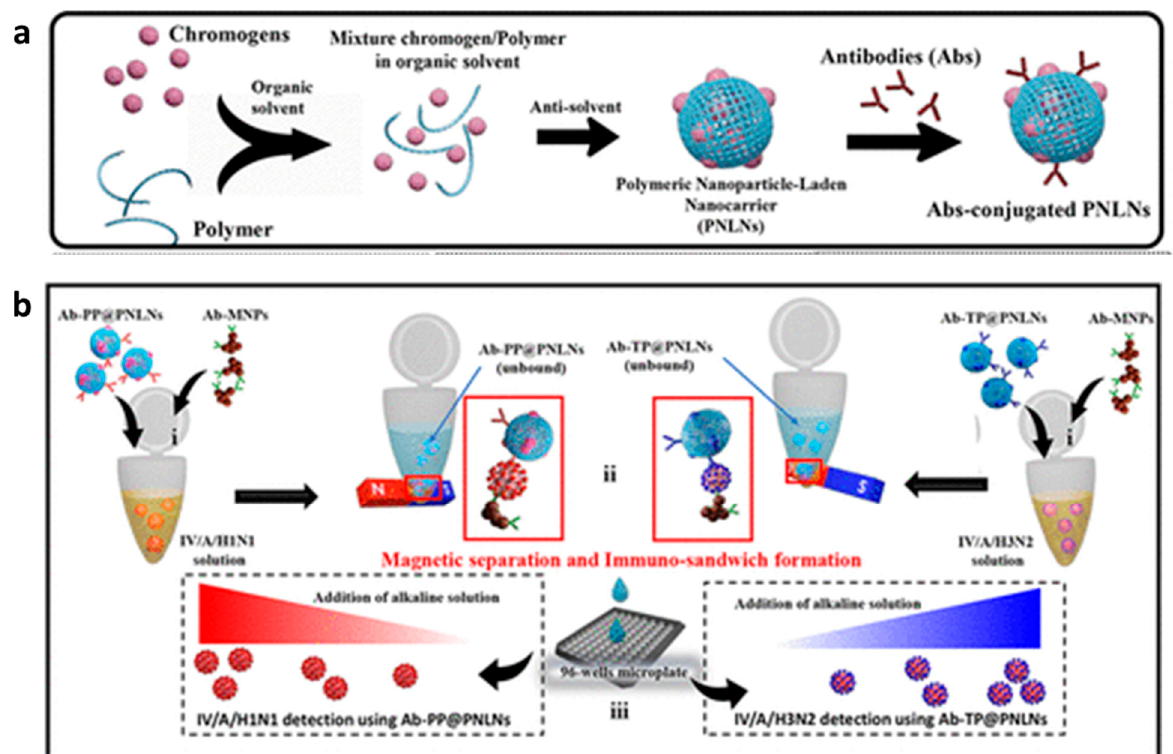
Figure 5. Representation of self-assembled chromogenic polymeric nanoparticle − laden nanocarrier as a signal carrier for derivative binary responsive virus detection. ( a ) Illustration of nanoparticle- laden nanocarrier preparation for immunoassay purposes. ( b ) Illustration of the influenza virus detection step of the nanoparticle-laden nanocarrier. Adapted with permission from [44]. Copyright 2021, American Chemical Society.